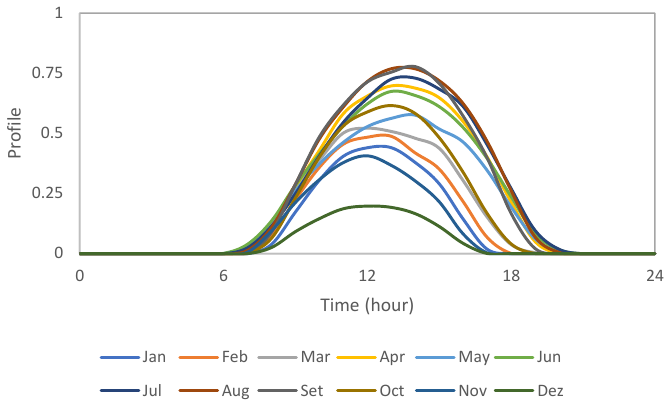
Figure A2. Average daily PV generation profiles, per month.